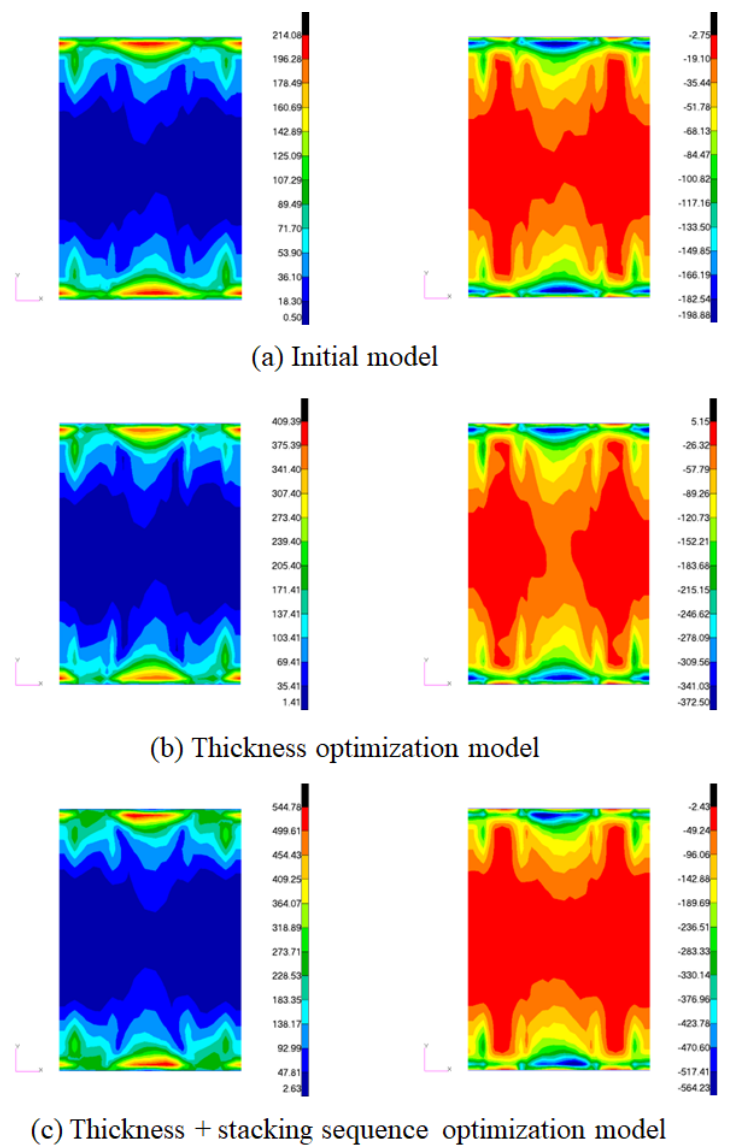
Figure 16. Comparison of stress σ xx results (left: tension, right: compression).